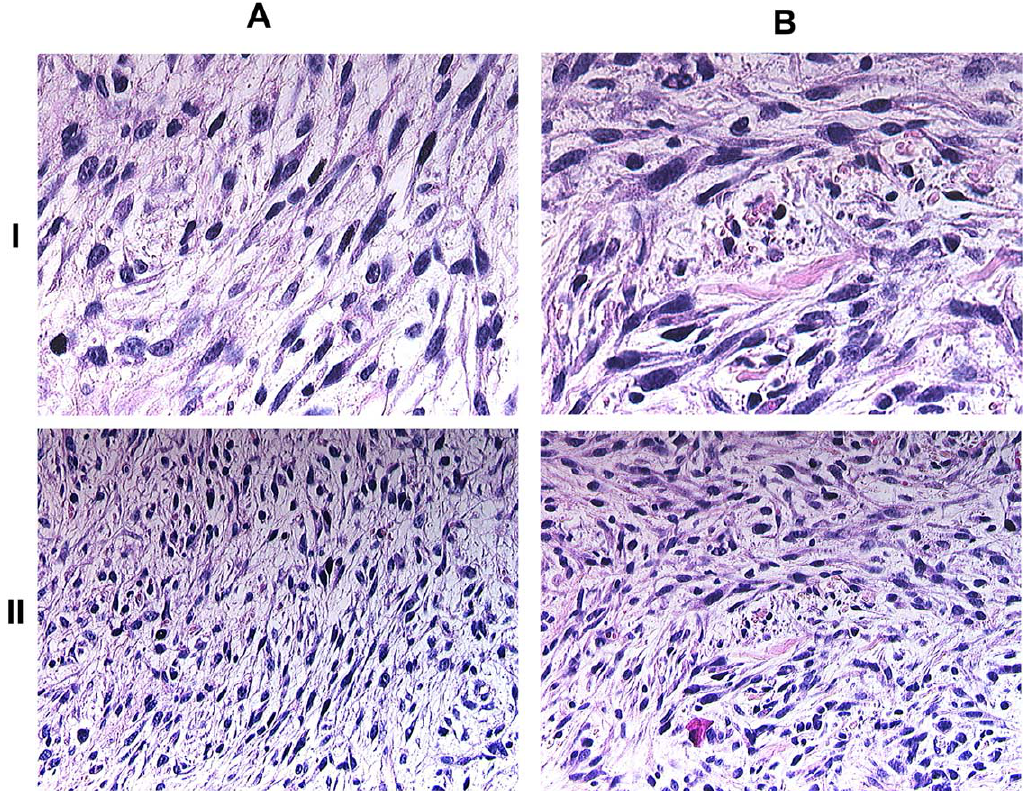
Fig. 6. Hematoxylin & Eosin staining of formaldehyde-fixed paraffin-imbedded sections of solid tumors formed by NIH191-10 (A, mouse no. 1; B, mouse no. 4). Field I, magnification × 40; field II, × 20.